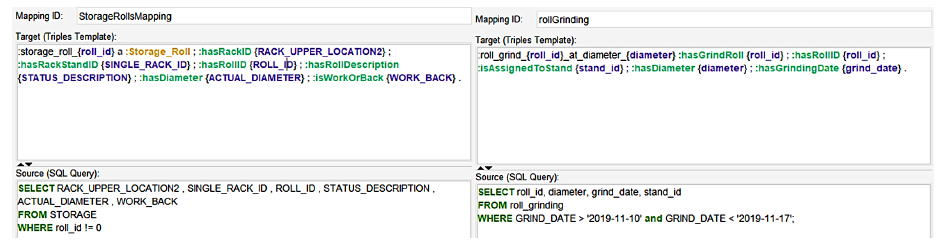
Figure 6. Ontop mapping for grindings and storage